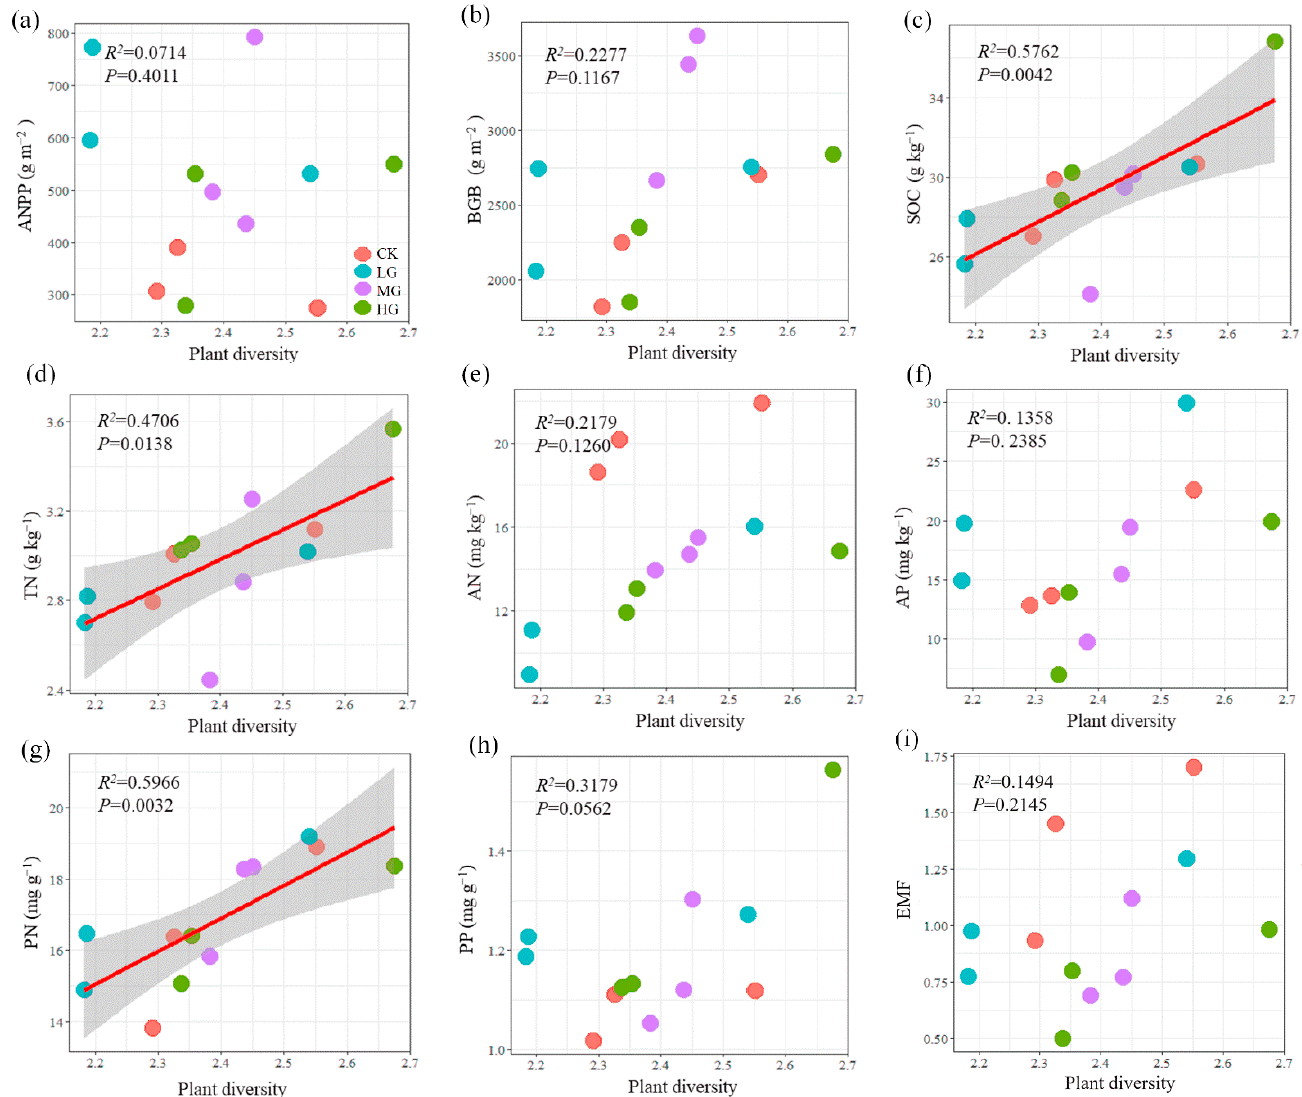
Figure 4. Relationships between plant diversity and ecosystem function indicators ( a – h ) and ecosystem multifunctionality (EMF) ( i ) under grazing. The solid lines indicate statistically significant relationships ( p < 0.05). Shaded areas show the 95% confidence interval of the fit.